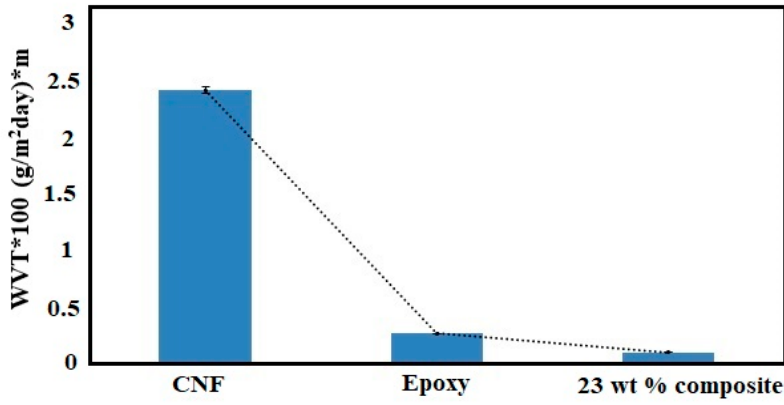
Figure 10. Water vapour transmission of the pure CNF, epoxy, and the 23 wt % composite.